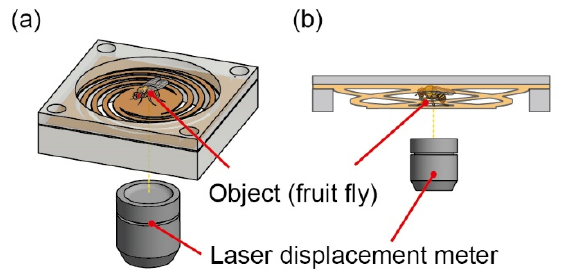
Figure 1. Schematics of the device’s in ( a ) bird’s-eye view and ( b ) side view. The design details of the spiral-coil spring are shown in Figure 2. The overall dimen- sions were 25 × 25 mm, and the central plate was circular with a diameter of 10 mm. The spiral coil had the same shape as the Archimedes spiral. The four coils were equally spaced with a phase difference of 90° and did not interfere with each other. The longer the length of the spiral, the smaller the spring constant. Figure 2. Detailed design and parameters of four types of force plate. We define the radius at any point on the spiral as r [mm] and the central angle as θ [rad]. When coil width w [mm] and pitch p [mm] are determined, the relationship between r and θ is given by Equations (1) and (2). 𝑟 = 5 − 𝑤 2 + 𝑝 𝜃 2 𝜋 (0 ≤ 𝜃 ≤ 𝜃 (cid:3040)(cid:3028)(cid:3051) )